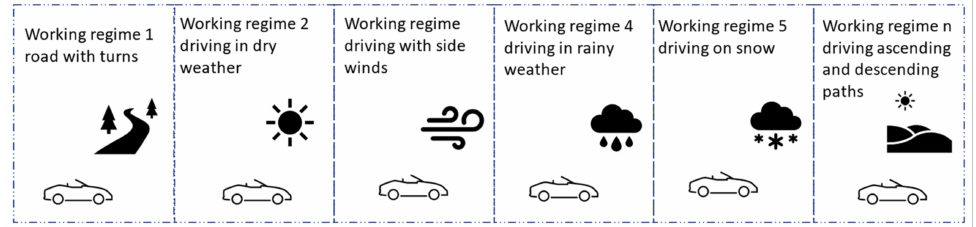
Figure 1. Example of working regimes a plane may encounter during its trip. Depending on weather conditions and drive path, several different controllers might be needed for its direction system.